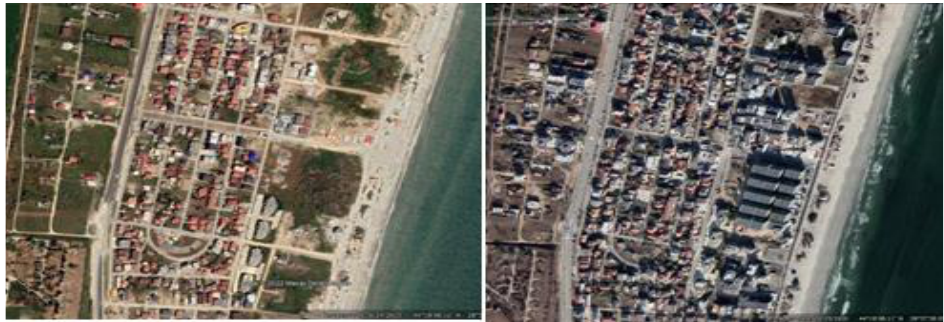
Figure 11. Development o f the accommodation infrastructure in Năvodari, Constanţa : 2015 ( left )